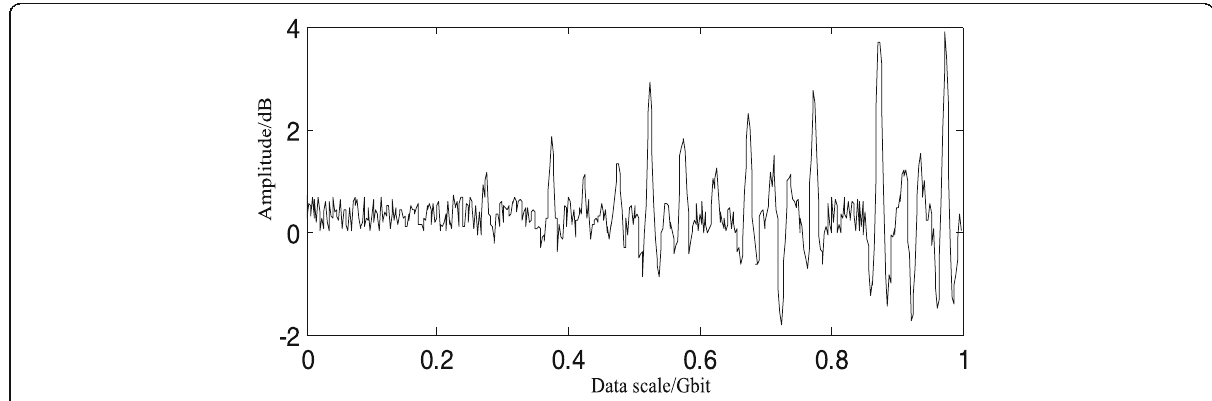
Fig. 3 Time domain map of original accounting